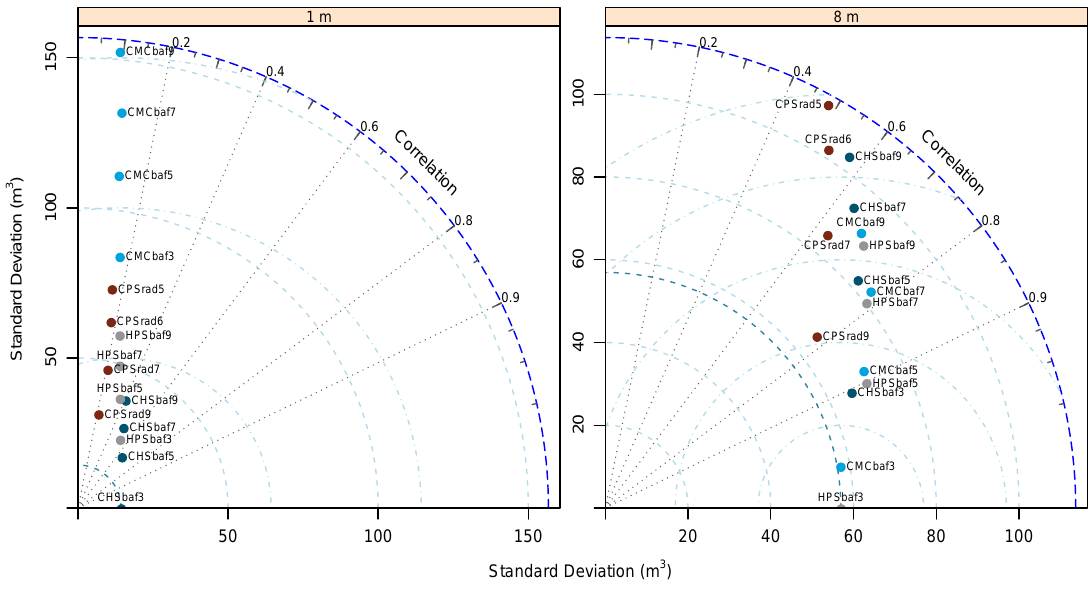
Figure 5. MODWT Taylor diagrams for the simulations in Table 1 where the individual panels represent relationship (10) for wavelet decomposition distances τ (cid:48) wavelet variances only (in terms of their standard